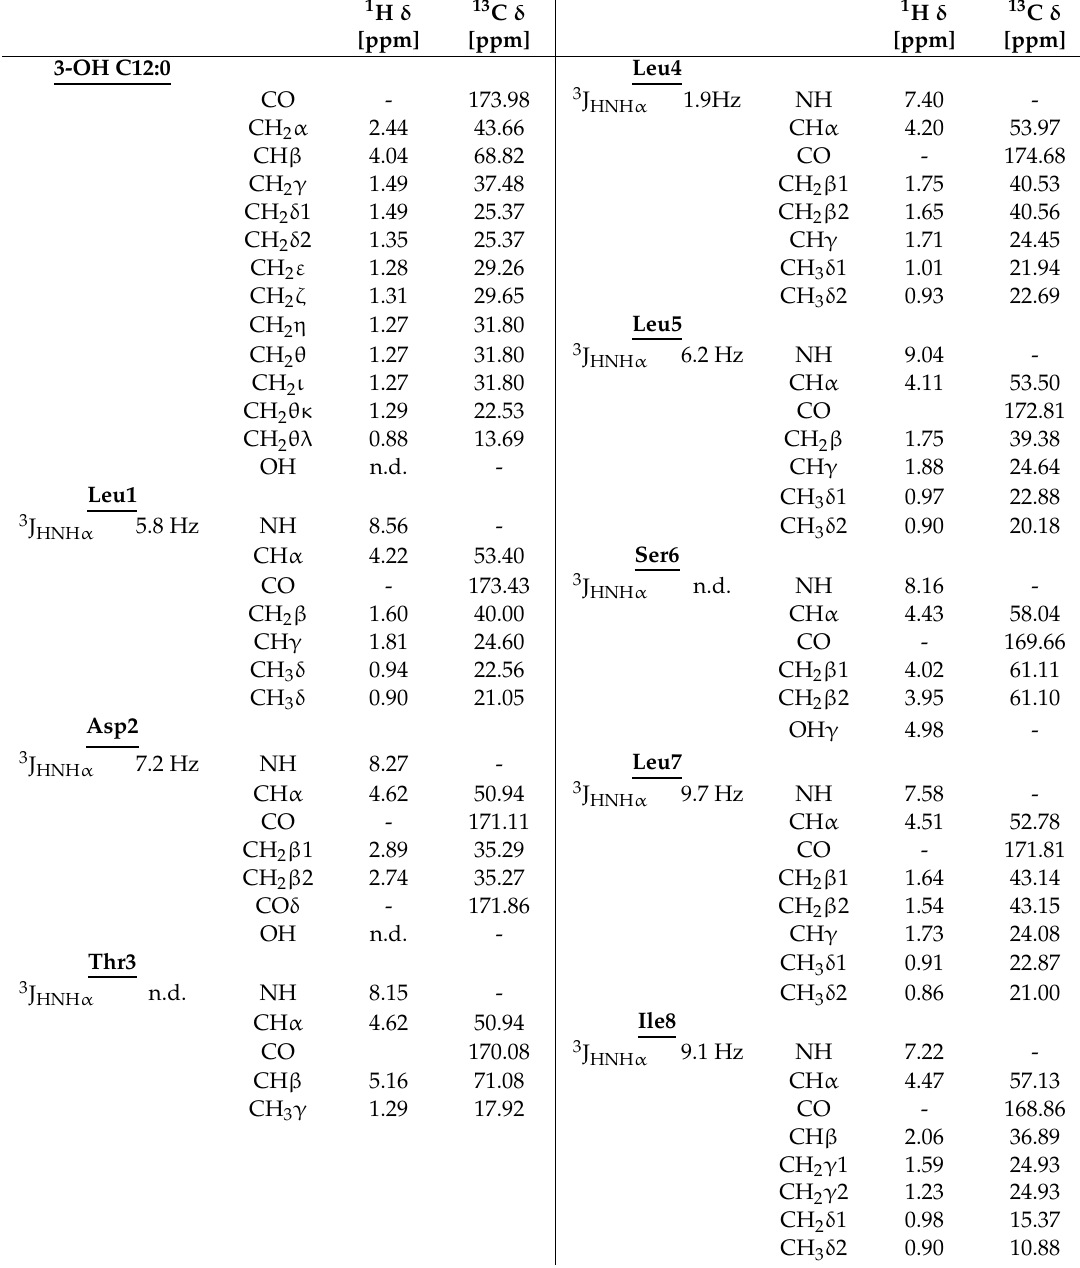
Table A2. 1 H and 13 C chemical shift of ‘bananamide E’ at retention time 13.9 min, in DMF-d7 (298 K, 500